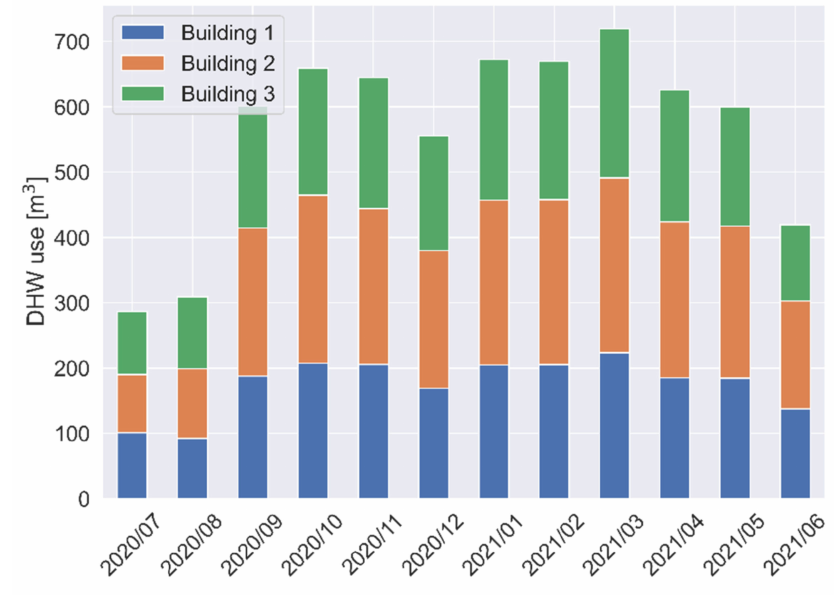
Figure 14. Monthly DHW use of all the apartments of Testbed